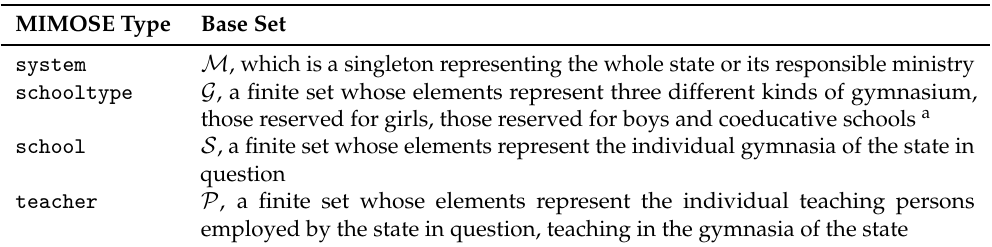
Table 1. MIMOSE types and base